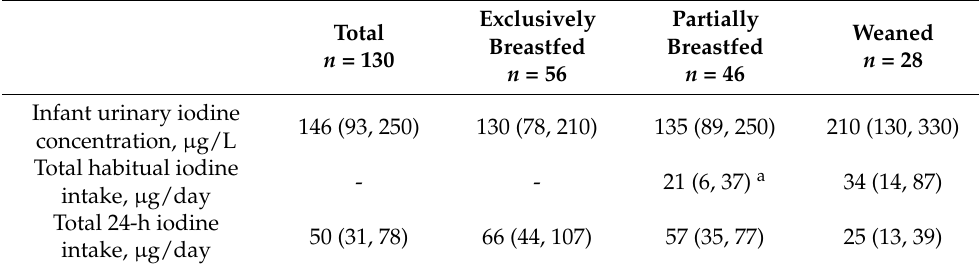
Table 2. Urinary iodine concentration ( µ g/L) and calculated iodine intake ( µ g/day) for the infants ( n = 130). Numbers are presented as median